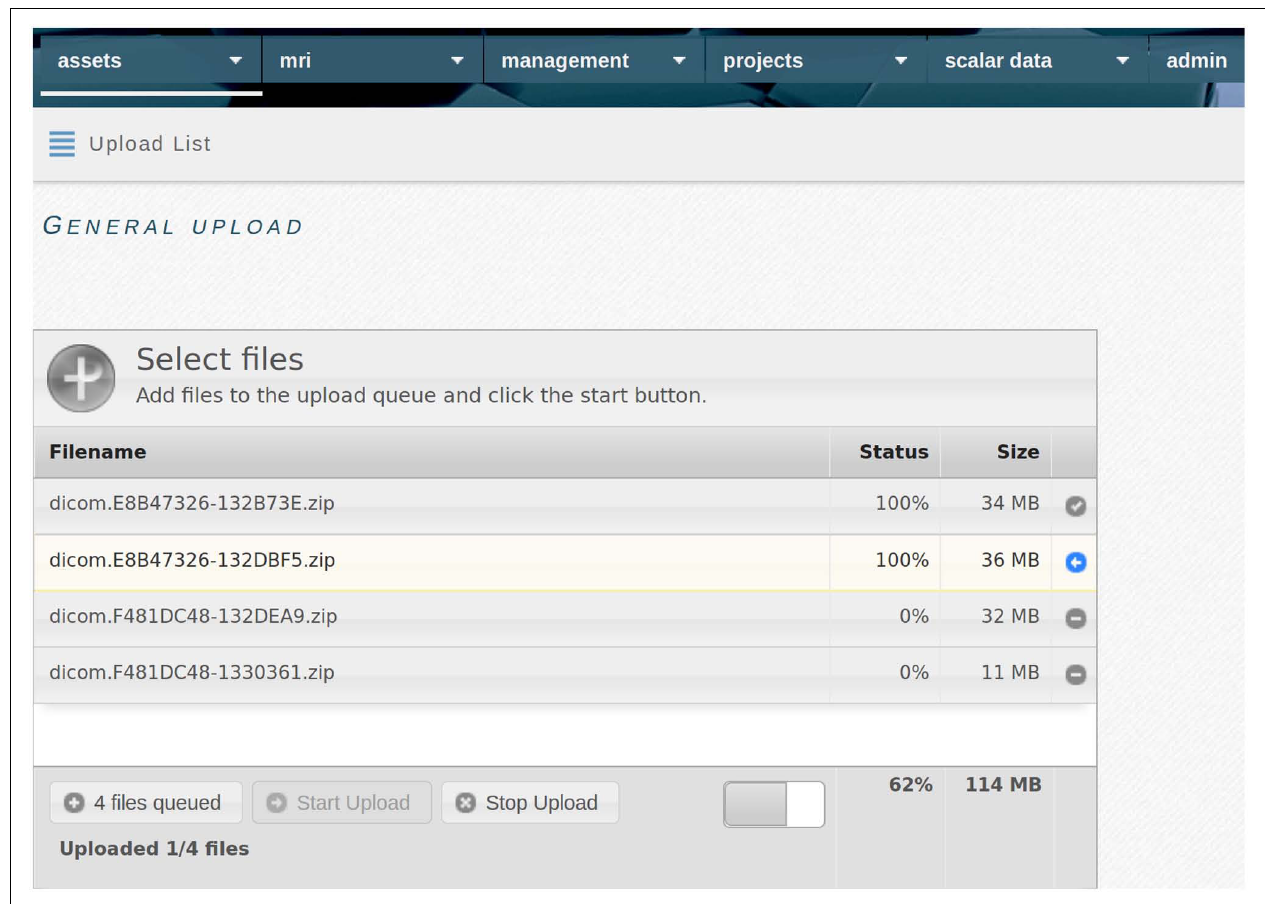
FIGURE 2 |TheHiveDB features a web based upload interface, which allows local data to be uploaded to the database. The multi file upload allows for drag and drop and shows upload